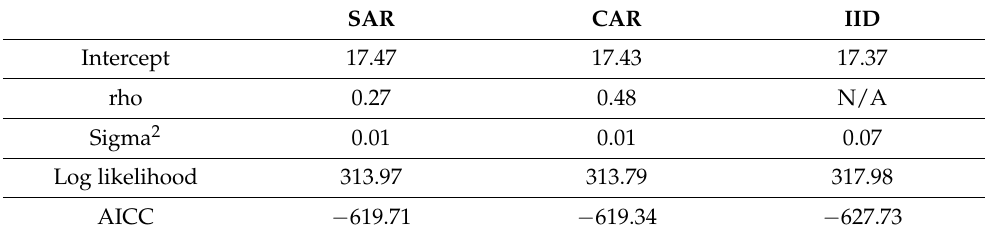
Table 3. A table comparing SAR, CAR, and IID (no spatial) models.